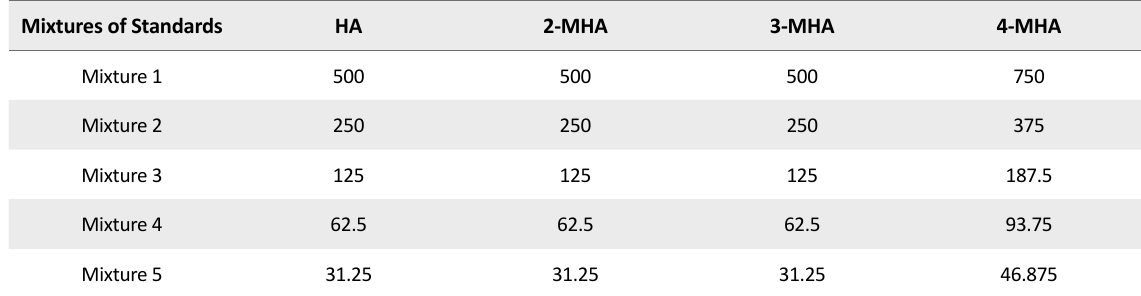
Table 2. Concentrations of different mixtures of standards (mg/L) Mixtures of